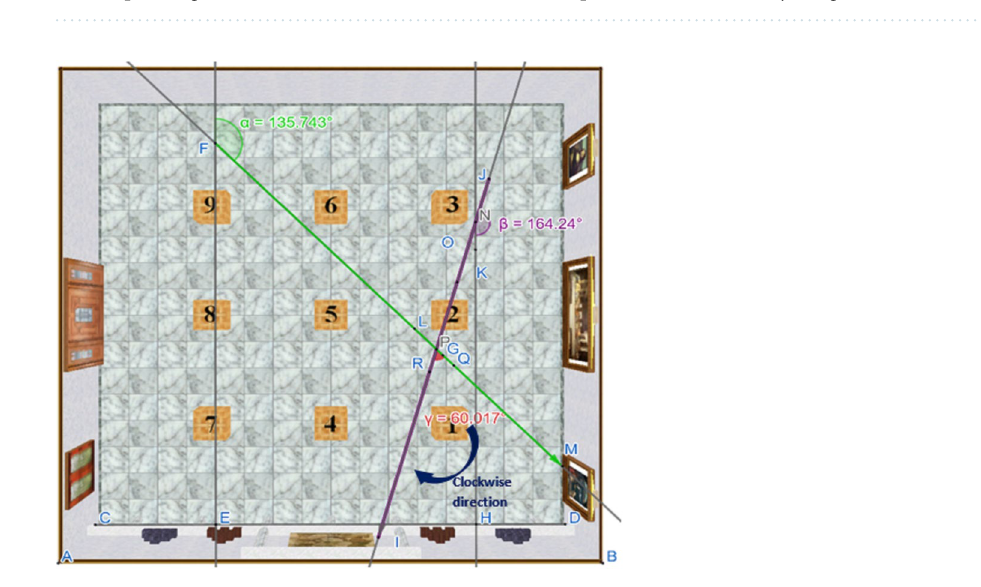
Figure 1. Stimuli sequence (from left to right) of one trials of higher difficulty level (three boxes) of the ASMRT. In the memorization phase, participants need to retain the position of the boxes colored in green. In the recognition phase, ten images were displayed one after another. For each of them, participants needed to identify if the green box was in the same place as the previously memorized. Every recognition image, as seen in the sample images, was in a different orientation when compared with the memory image.